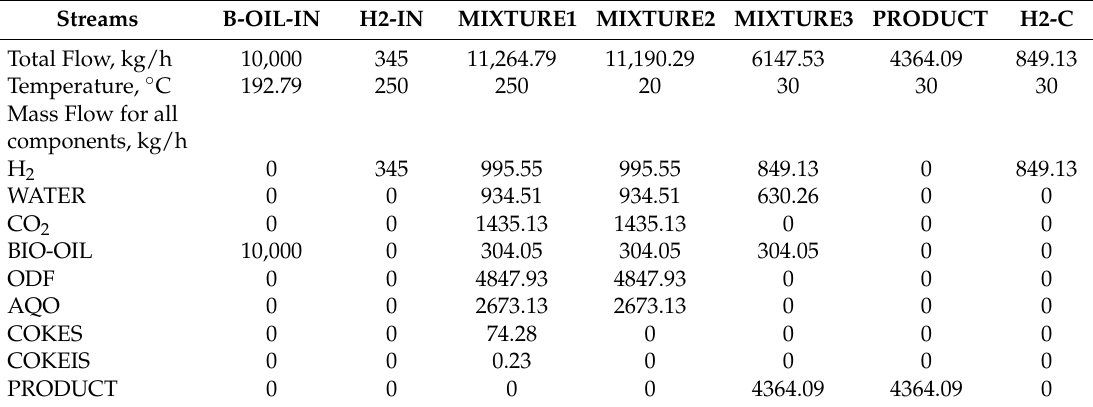
Table A1. Simulated results for main streams of products from mild hydrogenation of bio-oil at 250 ◦ C and 5.6 MPa and deep hydrogenation at 400 ◦ C and 15 MPa.